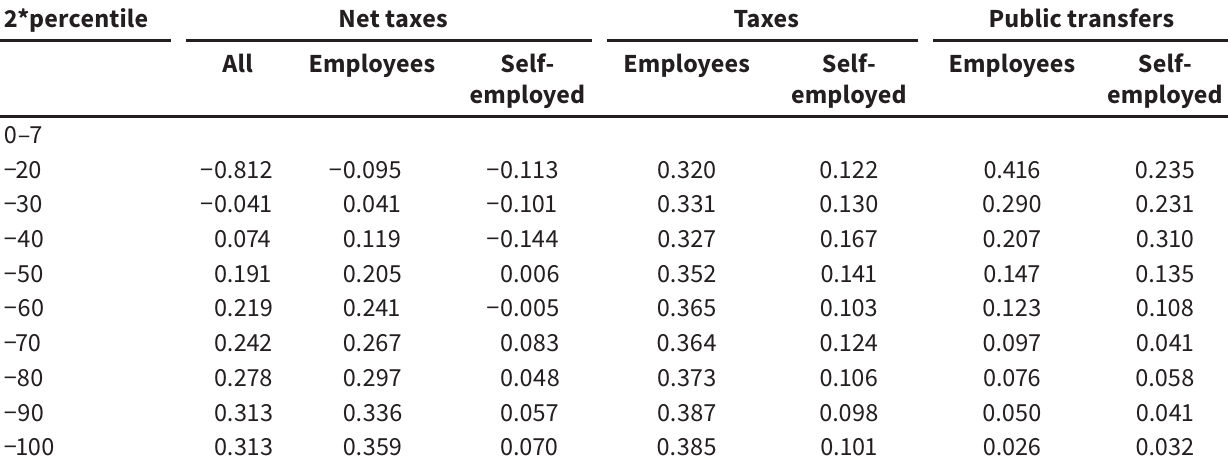
Household average effective net tax rates in Lithuania, net taxes as a share of gross employment income